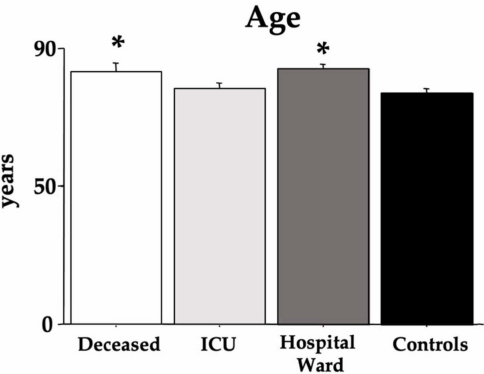
Figure 1. Age of the COVID-19 patients. The error bars indicate pooled standard error means (SEM) derived from the appropriate error mean square in the ANOVA. The asterisks ( p < 0.05) indicate post hoc differences with controls.